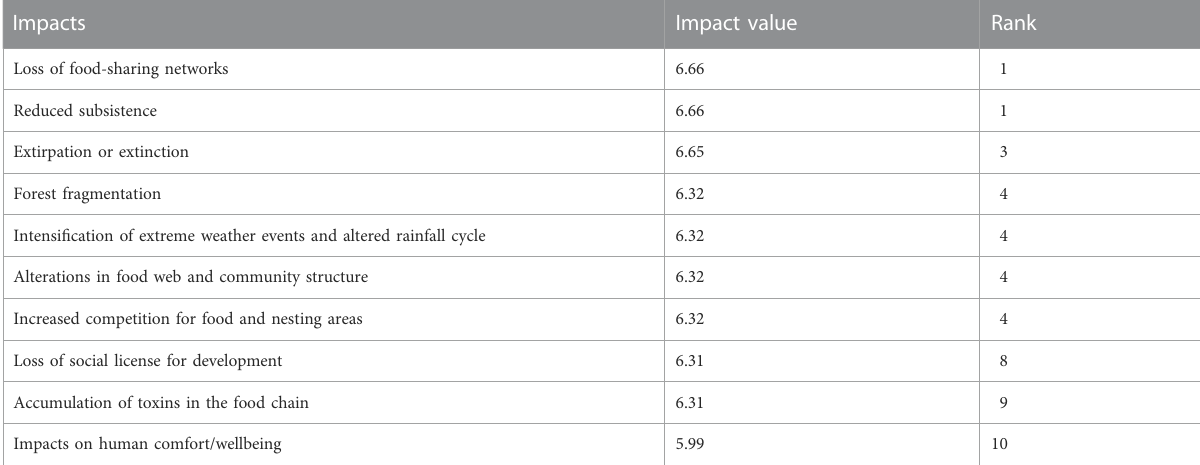
TABLE 4 Ten highest ranked impacts.